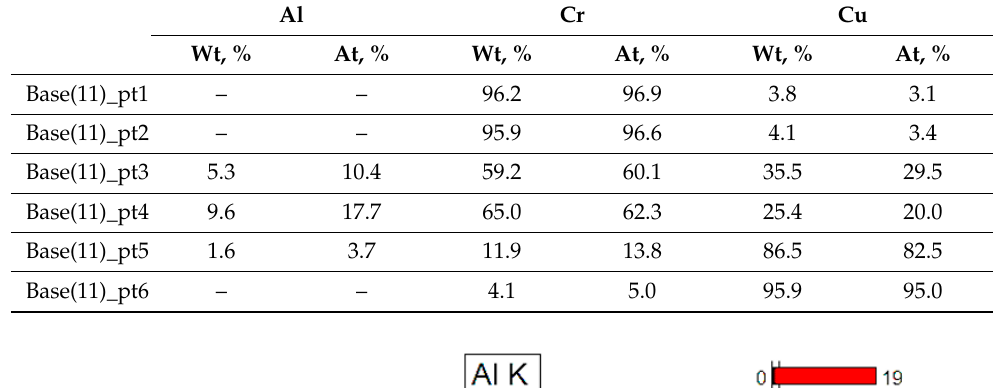
Table 1. Results of the quantitative EDS microanalysis of the chemical composition of the surface layer after fusion of CrAl powder into the surface of the guide rail and the sectional element made of Cu-ETP copper. Al Cr Wt, % At, %